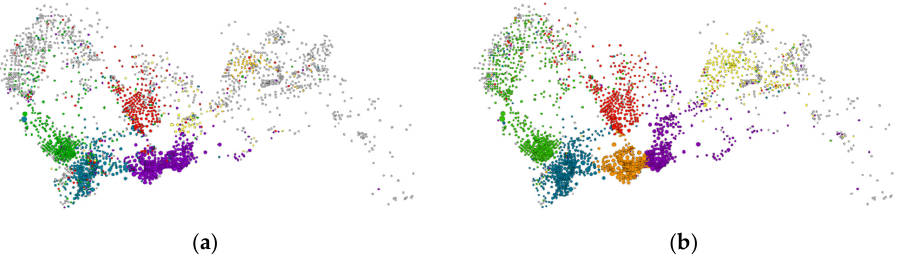
Figure 11. Community detection results of taxi daily flow network: ( a ) Community of weekdays; ( b ) community of weekends. ( b ) community of